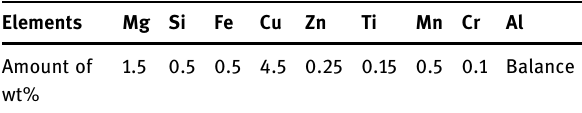
Table 2: Chemical composition of AA2024 - T351 alloy Elements